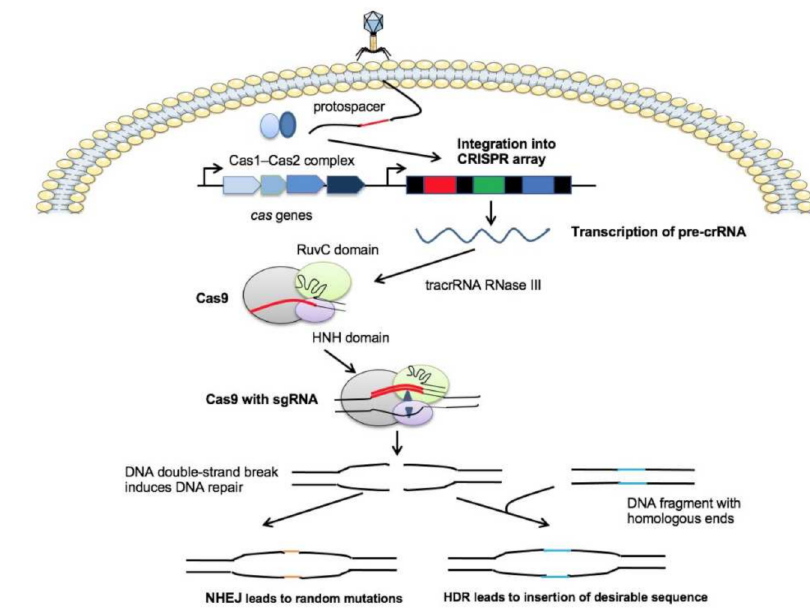
Figure 1. Molecular mechanism of the CRISPR-Cas 9 system. CRISPR-Cas systems are composed of a cas operon (blue arrows) and a CRISPR array which identical repeat sequences (black rectangles) that are interspersed by phage-derived spacers (colored rectangles). Upon phage infection, a sequence of the invading DNA (protospacer) is incorporated into